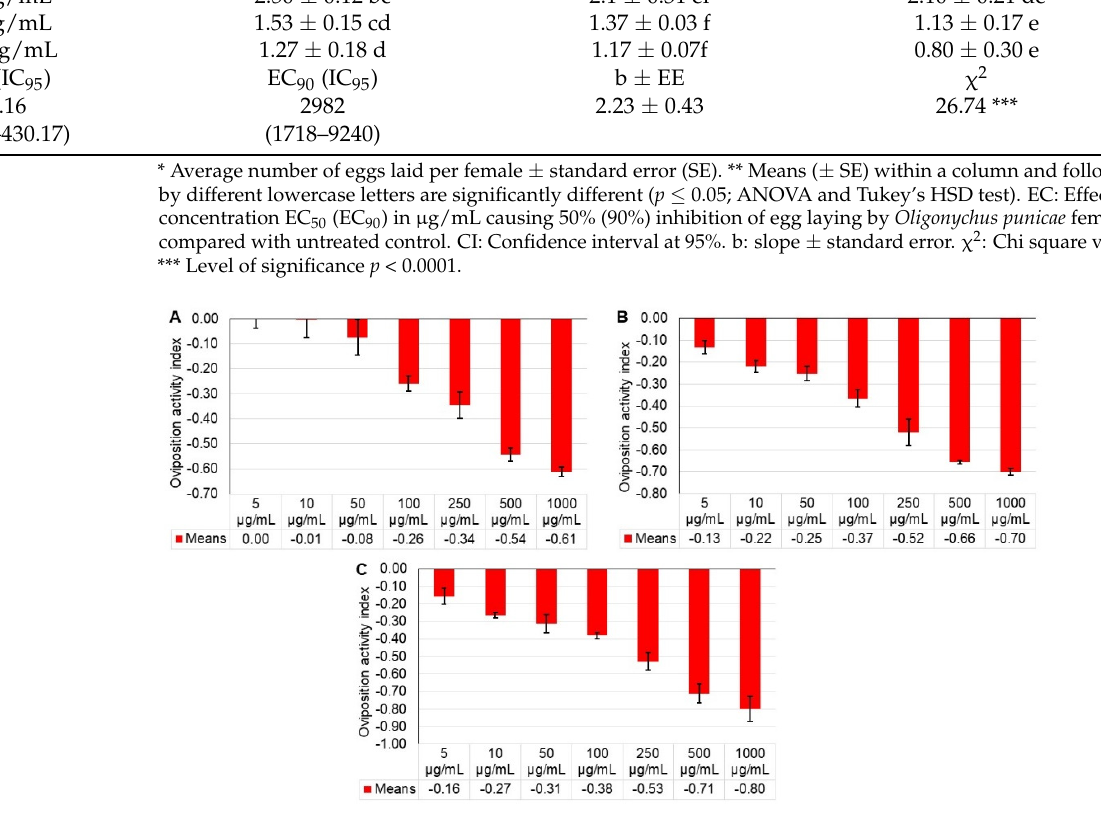
Figure 1. Ovipositional activity index (mean ± standard error) for Oligonychus punicae in response to different concentrations of Magnolia tamaulipana ethanolic powdered extract at ( A ) 24 h, ( B ) 48 h, and ( C ) 72 h.